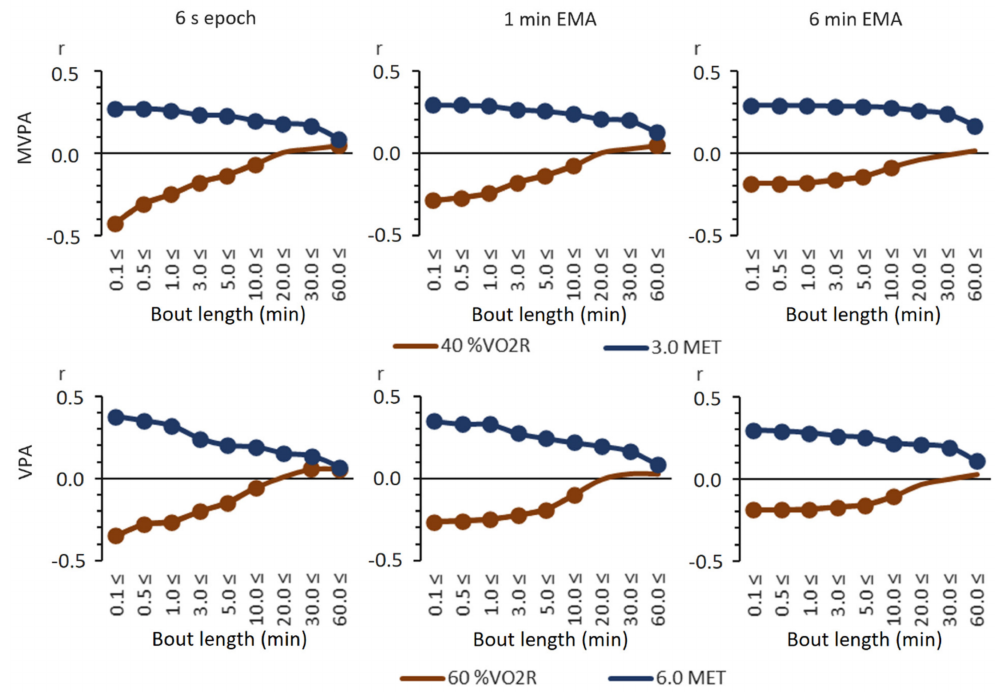
Figure 3. Partial Spearman correlations controlled for age, age 2 , and sex between VO 2 max and time accumulated from MVPA and VPA bouts at the time limit with absolute and relative thresholds. The x -axis is the time limit in minutes, and the y -axis is the correlation coefficient. The round marker on the line denotes a statistically significant correlation ( p <